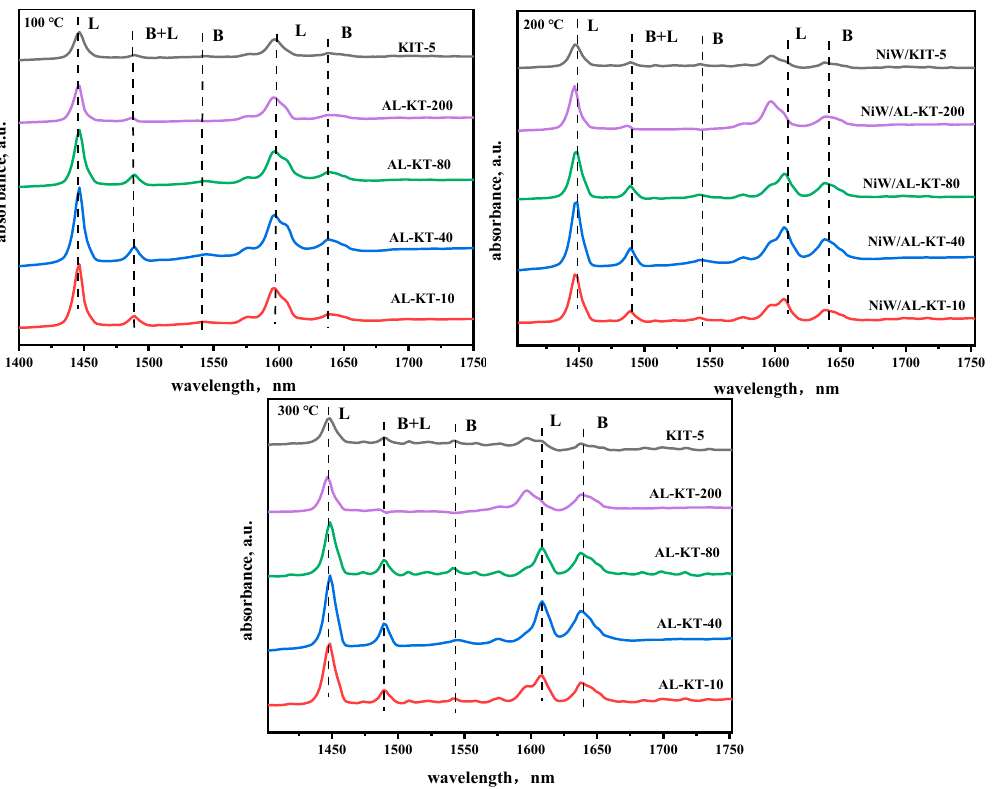
Figure 8. Pyridine-Fourier transform infrared spectroscopy (Py-IR) spectra of various catalysts at different temperatures.